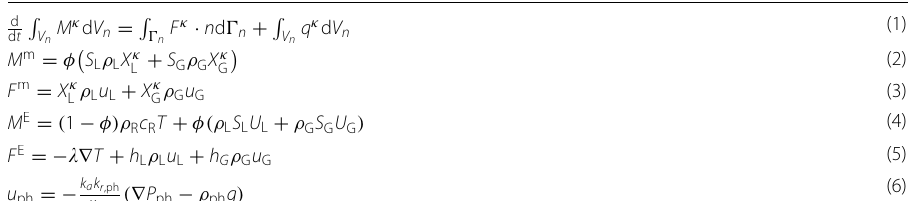
Table 1 Key reservoir equations